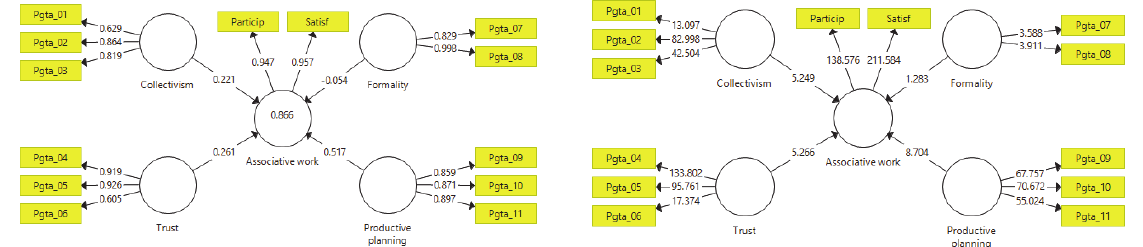
Fig. 3. Modeling of cultural aspects that influence the asso- ciative